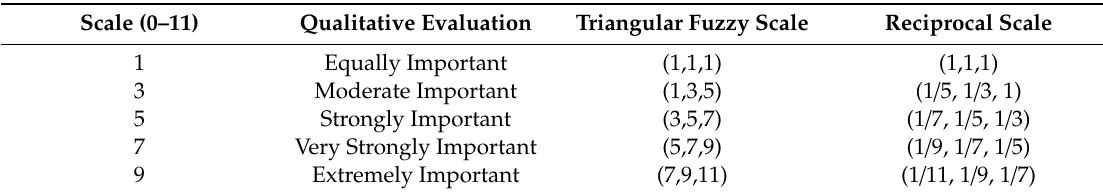
Table 2. Fuzzy triangular linguistic scale and fuzzy numbers.